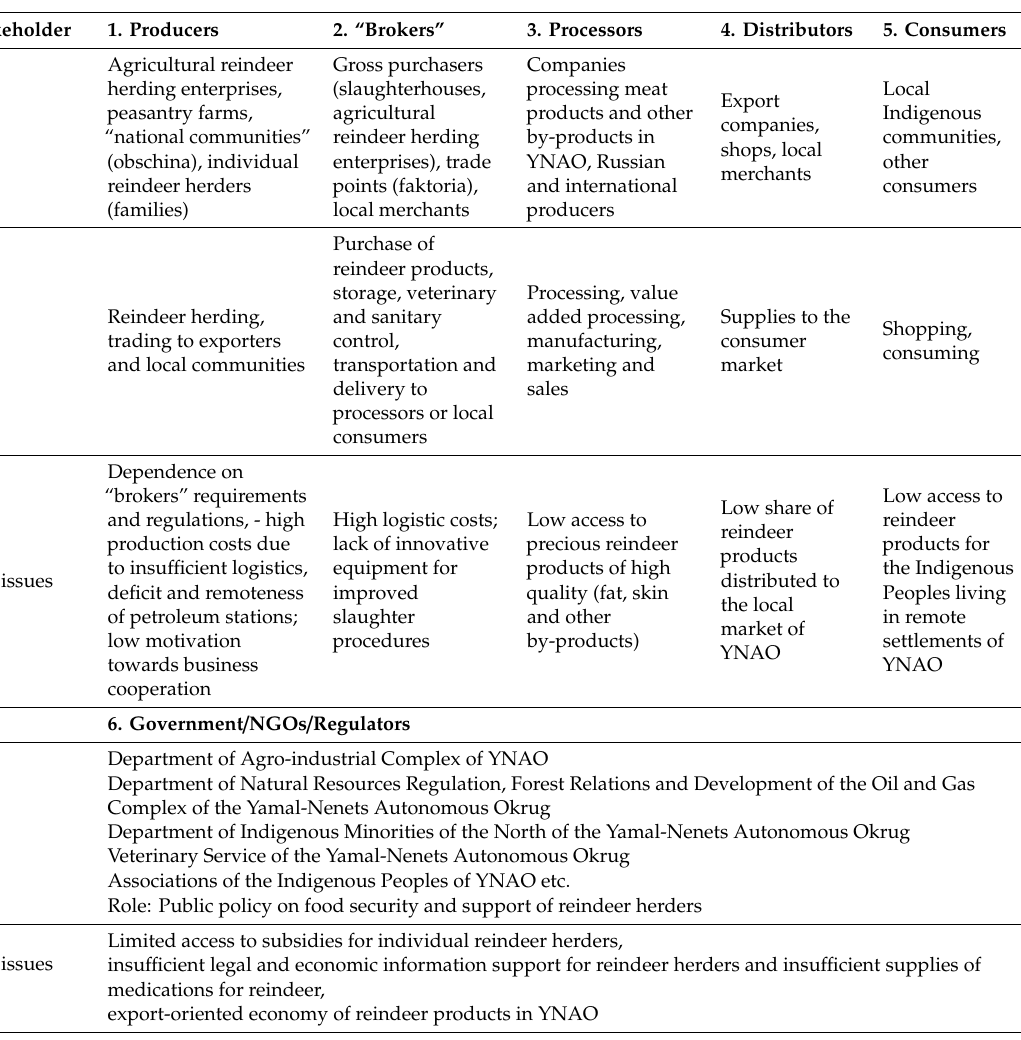
Table 1. Food value chain of reindeer herding products in the Yamal-Nenets Autonomous Okrug (YNAO).